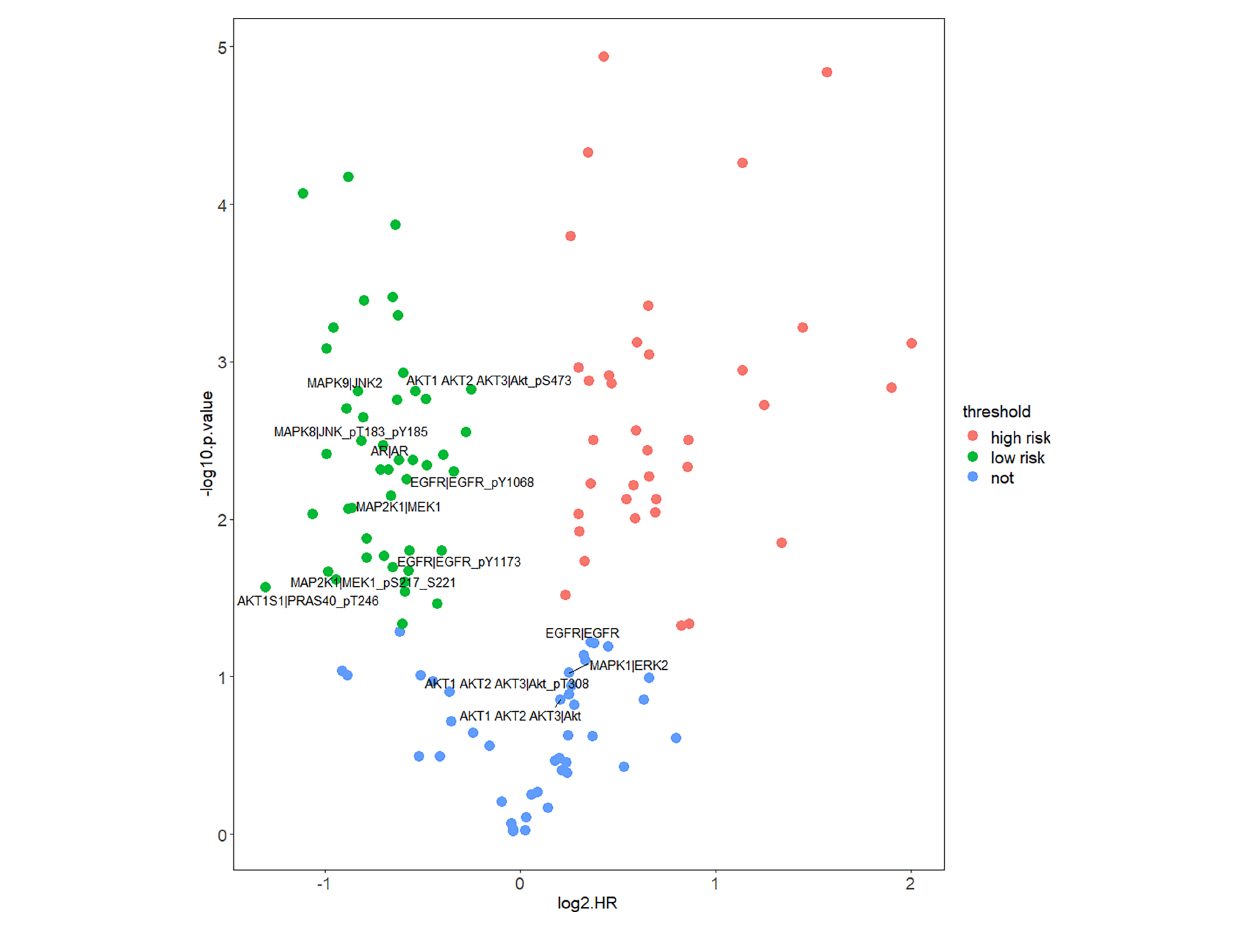
FIGURE 5 | Correlation of protein expression and HPV+ patients ’ survival. Figure shows COX proportional hazard regression. It measured correlation signi fi cance of protein expression and HPV+ patients ’ survival. Only differentially expressed proteins (DEPs) of HPV+ vs. HPV − are displayed. Proteins which p < 0.05 are signi fi cantly correlated with HPV+ patients ’ survival, log2HR >0 is positively correlated with survival, log2HR <0 is negatively correlated with